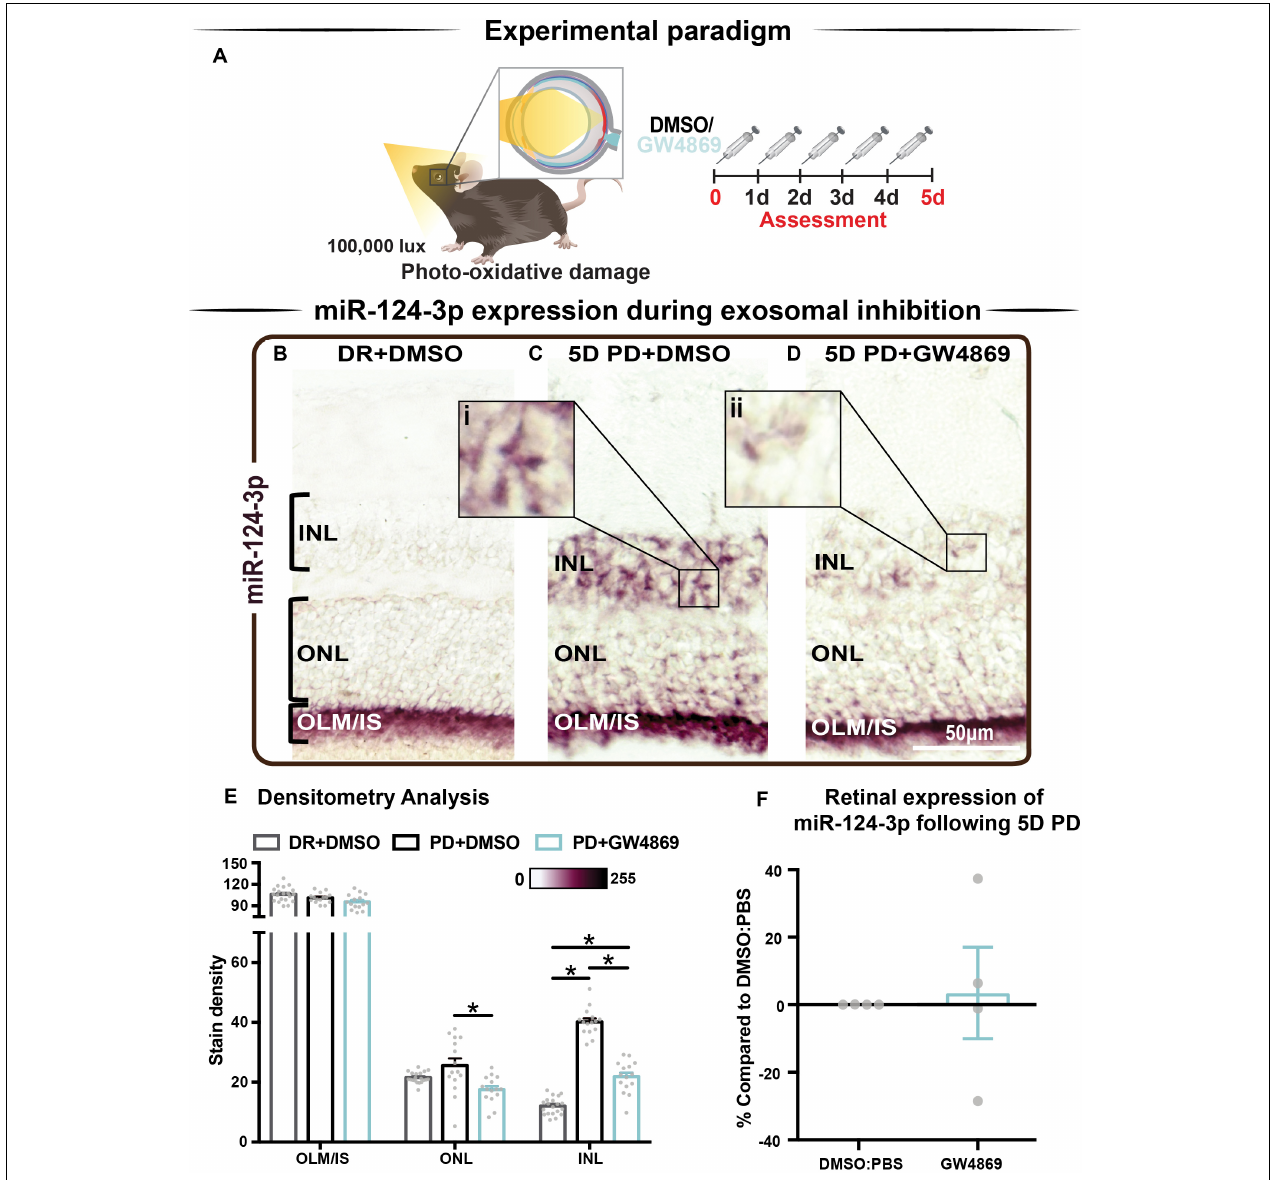
FIGURE 9 | s-mEV may mediate the translocation of miR-124-3p from the outer to inner retina during photo-oxidative damage-induced retinal degeneration. (A) Experimental paradigm with red retinal labeling indicating lesion site. (B) Using in situ hybridization, miR-124-3p expression in DR retinal cryosections was localized to the outer limiting membrane/photoreceptor inner segments (OLM, IS), however (C) following 5D PD, miR-124-3p was seen in the INL (inlet, i ). (D) Following intraperitoneal administration of GW4869 exosome inhibitor, miR-124-3p expression is significantly reduced in the ONL and INL (inlet, ii ). Representative images are taken in the superior outer retina, 1 mm from optic nerve head. (E) Densitometry analysis of miR-124-3p in retinal layers confirmed a decrease in miR-124-3p expression in the ONL and INL of mice treated with GW4869. (F) Retinal expression of miR-124-3p was conducted using qRT-PCR in photo-oxidative damaged mice treated with GW4869 or DMSO control, showing no change in total retinal expression ( P > 0.05). Scale bar = 50 µ M. * denotes = P <